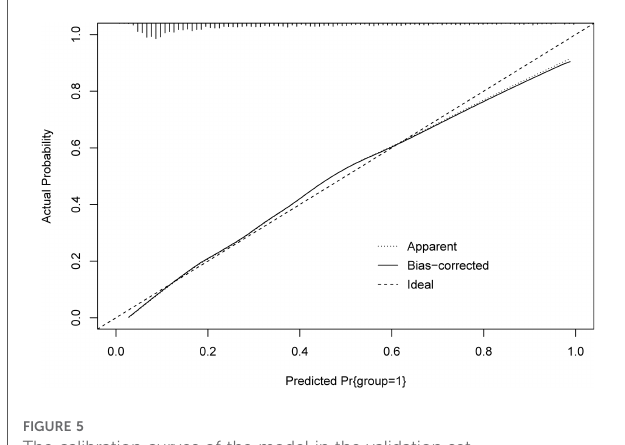
( Figure 7 ). The sensitivity and speci fi city of the prediction models for different cancer types were exhibited in Table 4 .